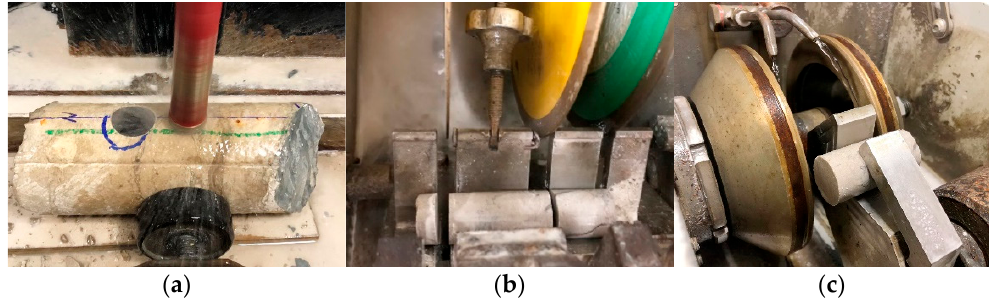
Figure 2. Stages of preparation of rock samples: ( a ) drilling of samples with a diameter of 25.4 mm; ( b ) cutting samples with a length of 50.8 mm; ( c ) grinding end surfaces to ensure parallelism.